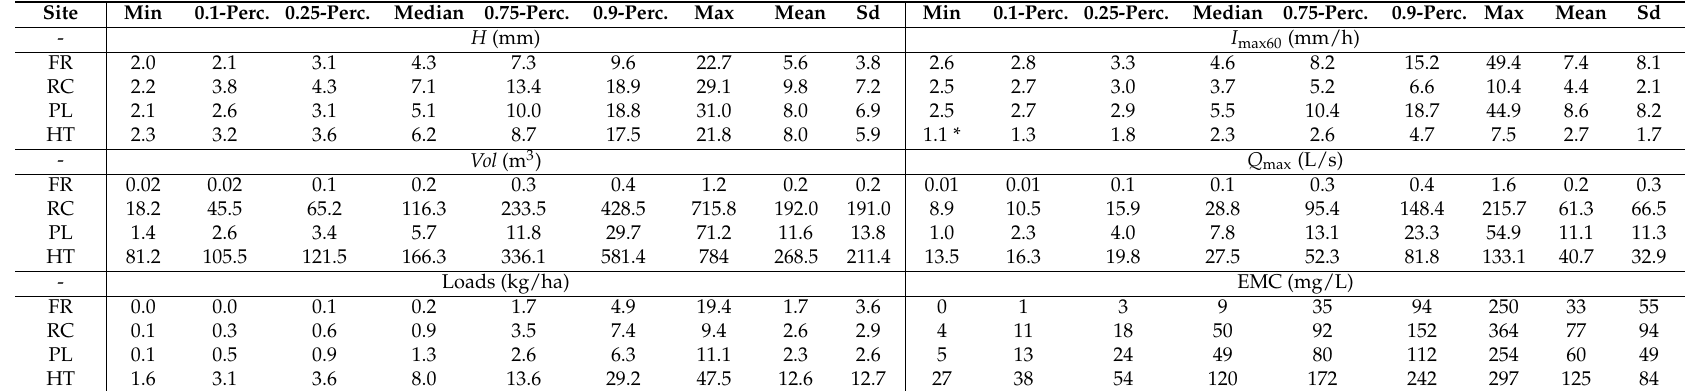
Table 5. Descriptive statistic data (min, 0.1-, 0.25-, 0.5-, 0.75-, 0.9-percentiles, max, mean, standard deviation) of site-specific event characteristics; rainfall depth: